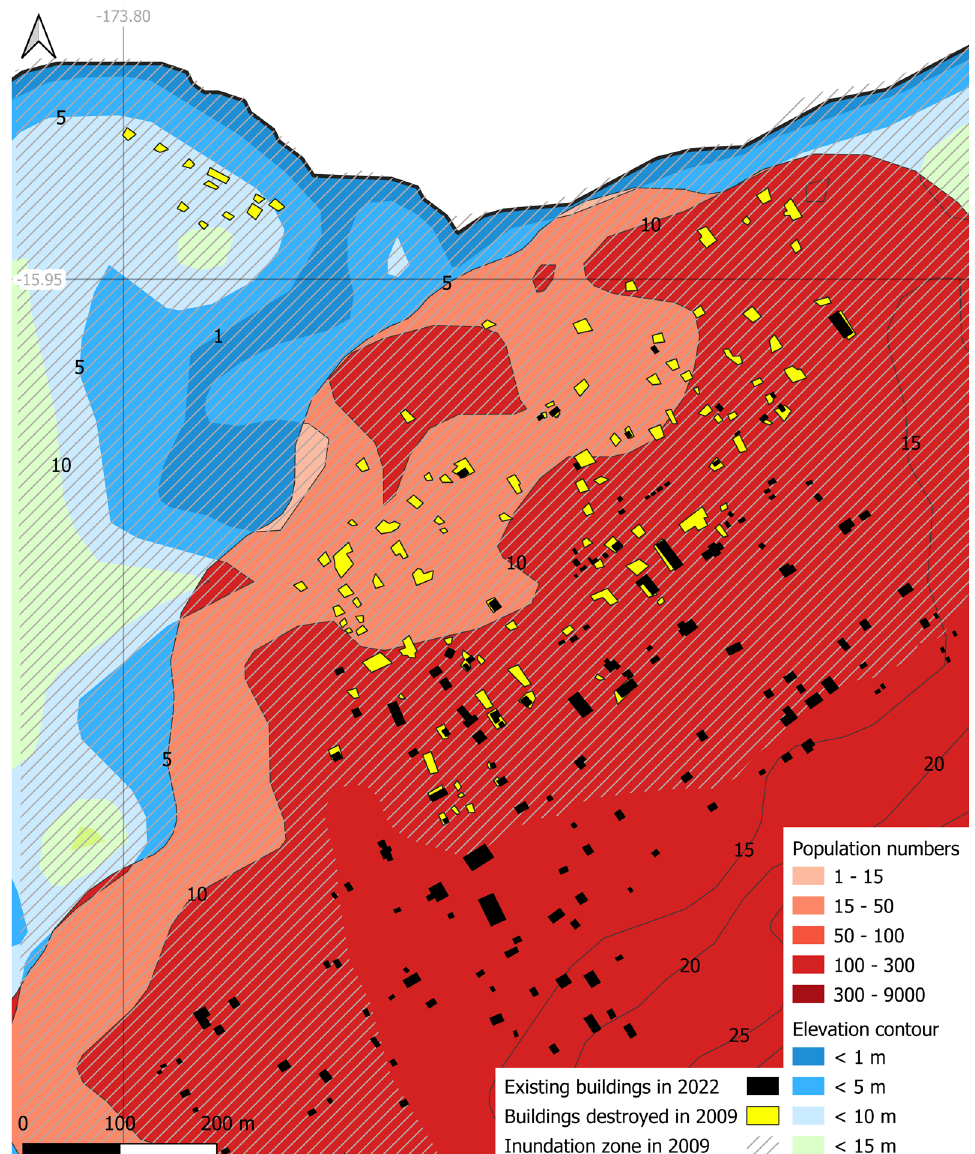
Fig. 9 Hihifo village layout with overlay of destroyed buildings during the 2009 tsunami. Black polygons: buildings included in this study (OCHA 2022c). Yellow polygons: buildings damaged during the 2009 tsunami (Clark et al.